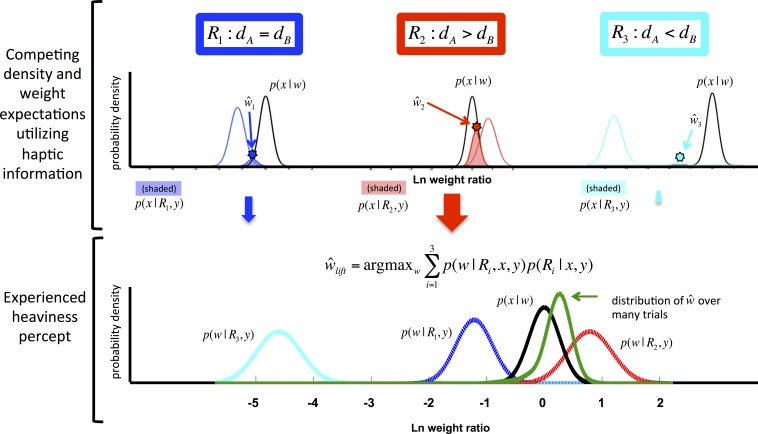
Depiction of the competitive prior framework.The “agreement” between the sensory evidence p(x|w) and competing expectations of w—depicted by the shaded regions, or p(x|Ri, y)—is greater for R2 than for the other Rs. When p(x|R2, y) is multiplied by the a priori probability of R2 to produce p(R2|x, y), it is clear that the expected weight relationship between the two objects under R2 will exert the most influence on the ultimate percept, \documentclass[12pt]{minimal}
\usepackage{amsmath}
\usepackage{wasysym}
\usepackage{amsfonts}
\usepackage{amssymb}
\usepackage{amsbsy}
\usepackage{upgreek}
\usepackage{mathrsfs}
\setlength{\oddsidemargin}{-69pt}
\begin{document}
}{}$\hat {w}$\end{document}w ˆ. In log space, values above 0 represent a felt or expected weight ratio in the SWI range (smaller is heavier). For an extended version of the graphical depiction, see the Supplemental Information.